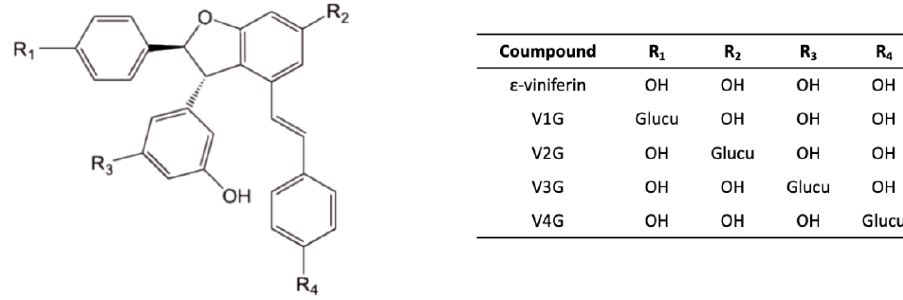
Figure 3. Structure of glucuronide metabolites of ε -viniferin. Glucu: glucuronide